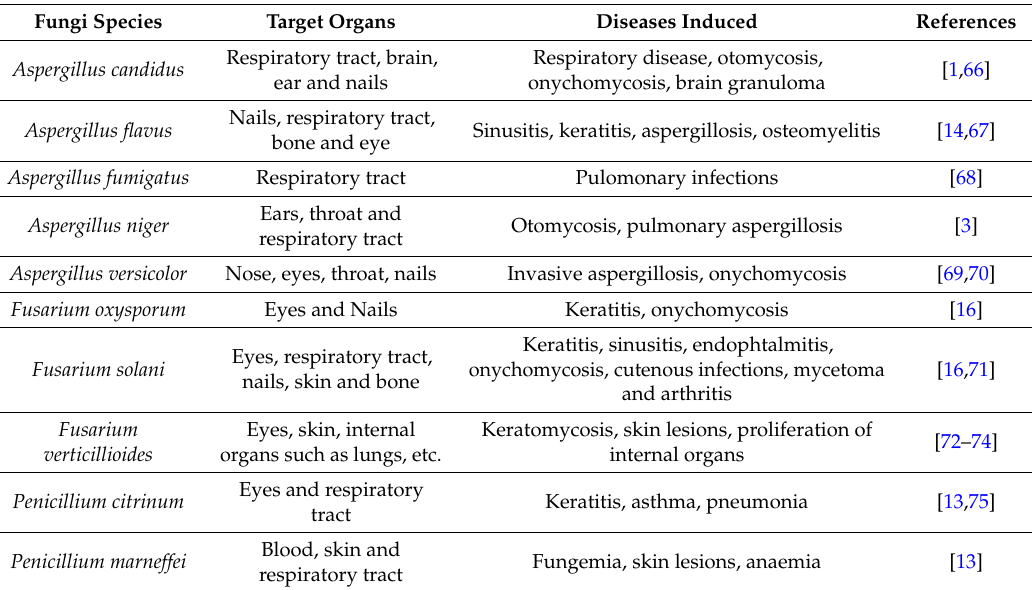
Table 3. Infections induced by fungi species and organs they